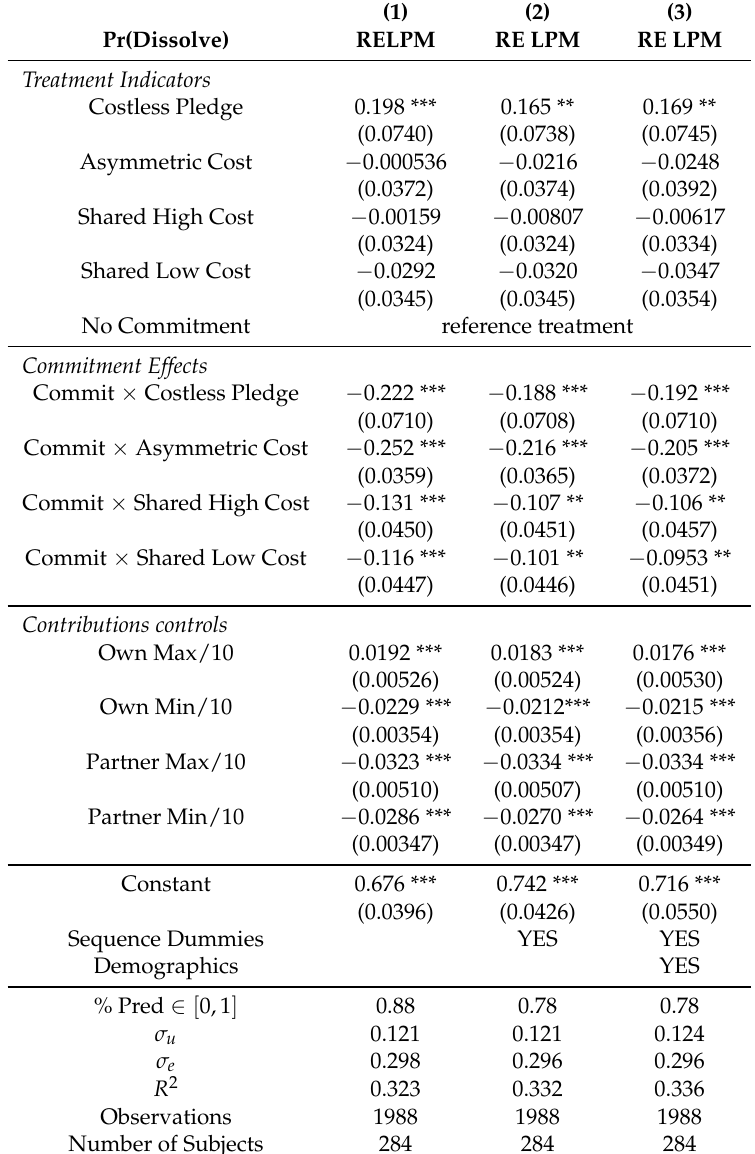
Table 5. Random effects linear probability model for partnership